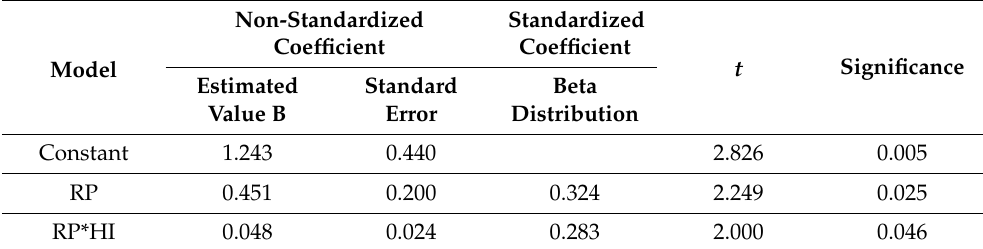
Table 5. Analysis of the interference effect of healthy image on ERP and place attachment.